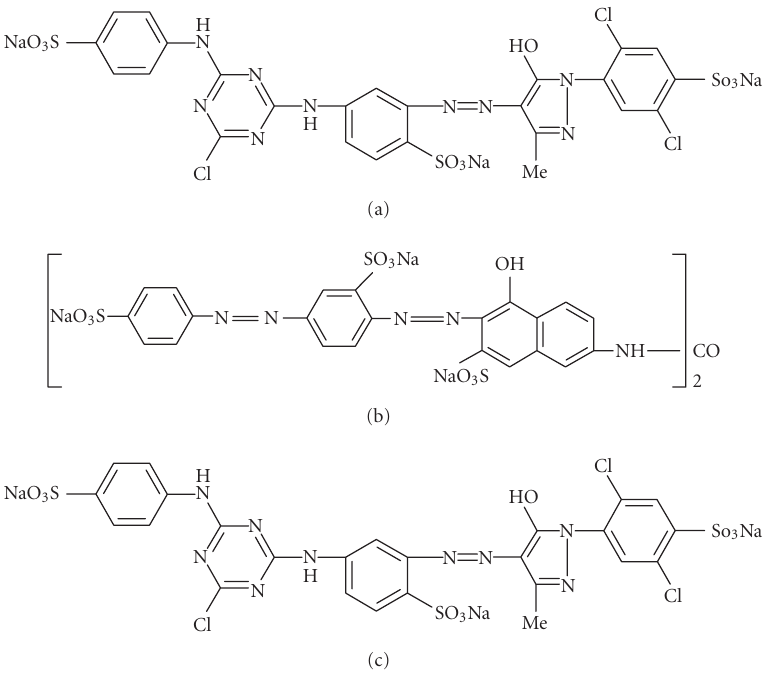
Figure 1: (a) Chemical structure of commercial diazo dye of Light Yellow X6G (C.I. Reactive Yellow 2). (b) Chemical structure of commercial diazo dye of Solophenyl red 3BL (C.I. Direct 80). (c) Chemical structure of commercial diazo dye of Tertrodirect light blue R (C.I. Direct blue 71).